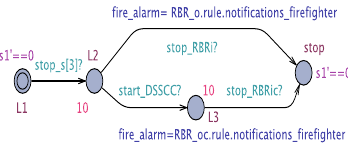
Figure 12. The monitor automaton for requirement R 1 CAMI .